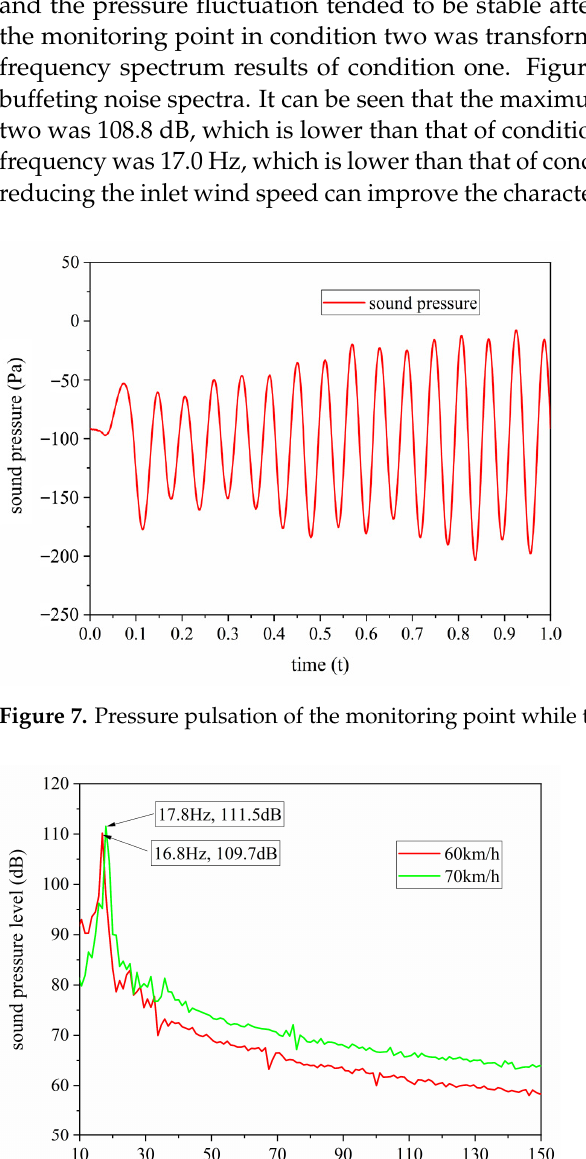
Figure 9. The pressure contour curve of the cab forehead with different speed. Figure 10 is a contour curve of the cab pressure when the inlet speed was 60 km/h. It can be seen that the turbulent vortex did not fall into the cab while it moved through the sunroof but continued to move backward with the airflow, which is the reason why the pressure fluctuation decreased while the inlet speed was 60 km/h. The simulation results show that improving the flow field characteristics above the cab has a good effect on re- ducing the sunroof buffeting noise.